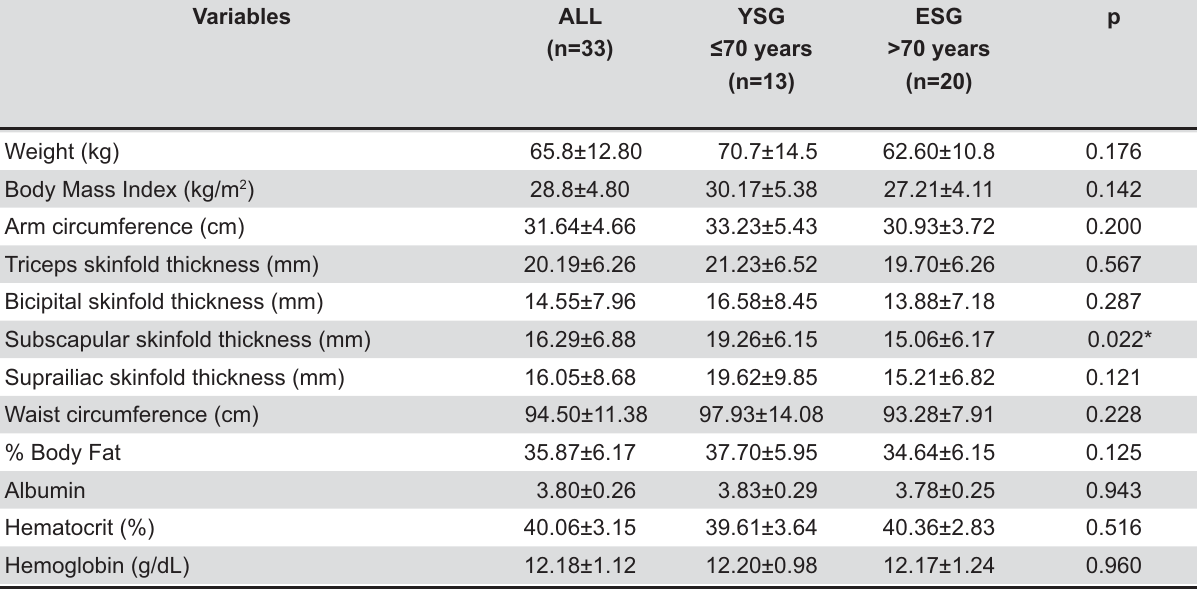
Table 2- Distribution of the sample in the Young Senior Group (YSG), aged less than 70 years, and the Elderly Senior Group (ESG), aged more than 70 years, by anthropometric indicators and clinical evaluation. (Student’s Unpaired t